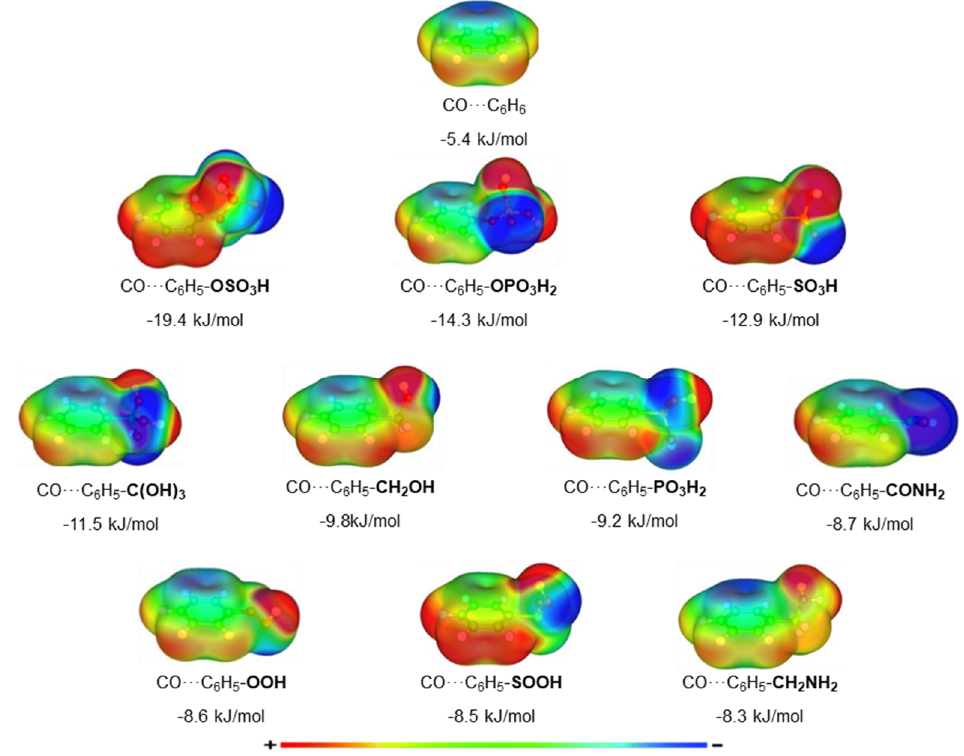
Figure 4. Electrostatic potential maps of the strongest interacting C 6 H 5 -X monomers. Calculated using the MP2/6-311++G ** method with ORCA 4.2 and visualized with gOpenMol [30,31] The varying intensities are ranging from −0.03 to +0.03 Hartree·e −1 . Red: electron-poor regions—high potential value, Blue: electron-rich regions— low potential.